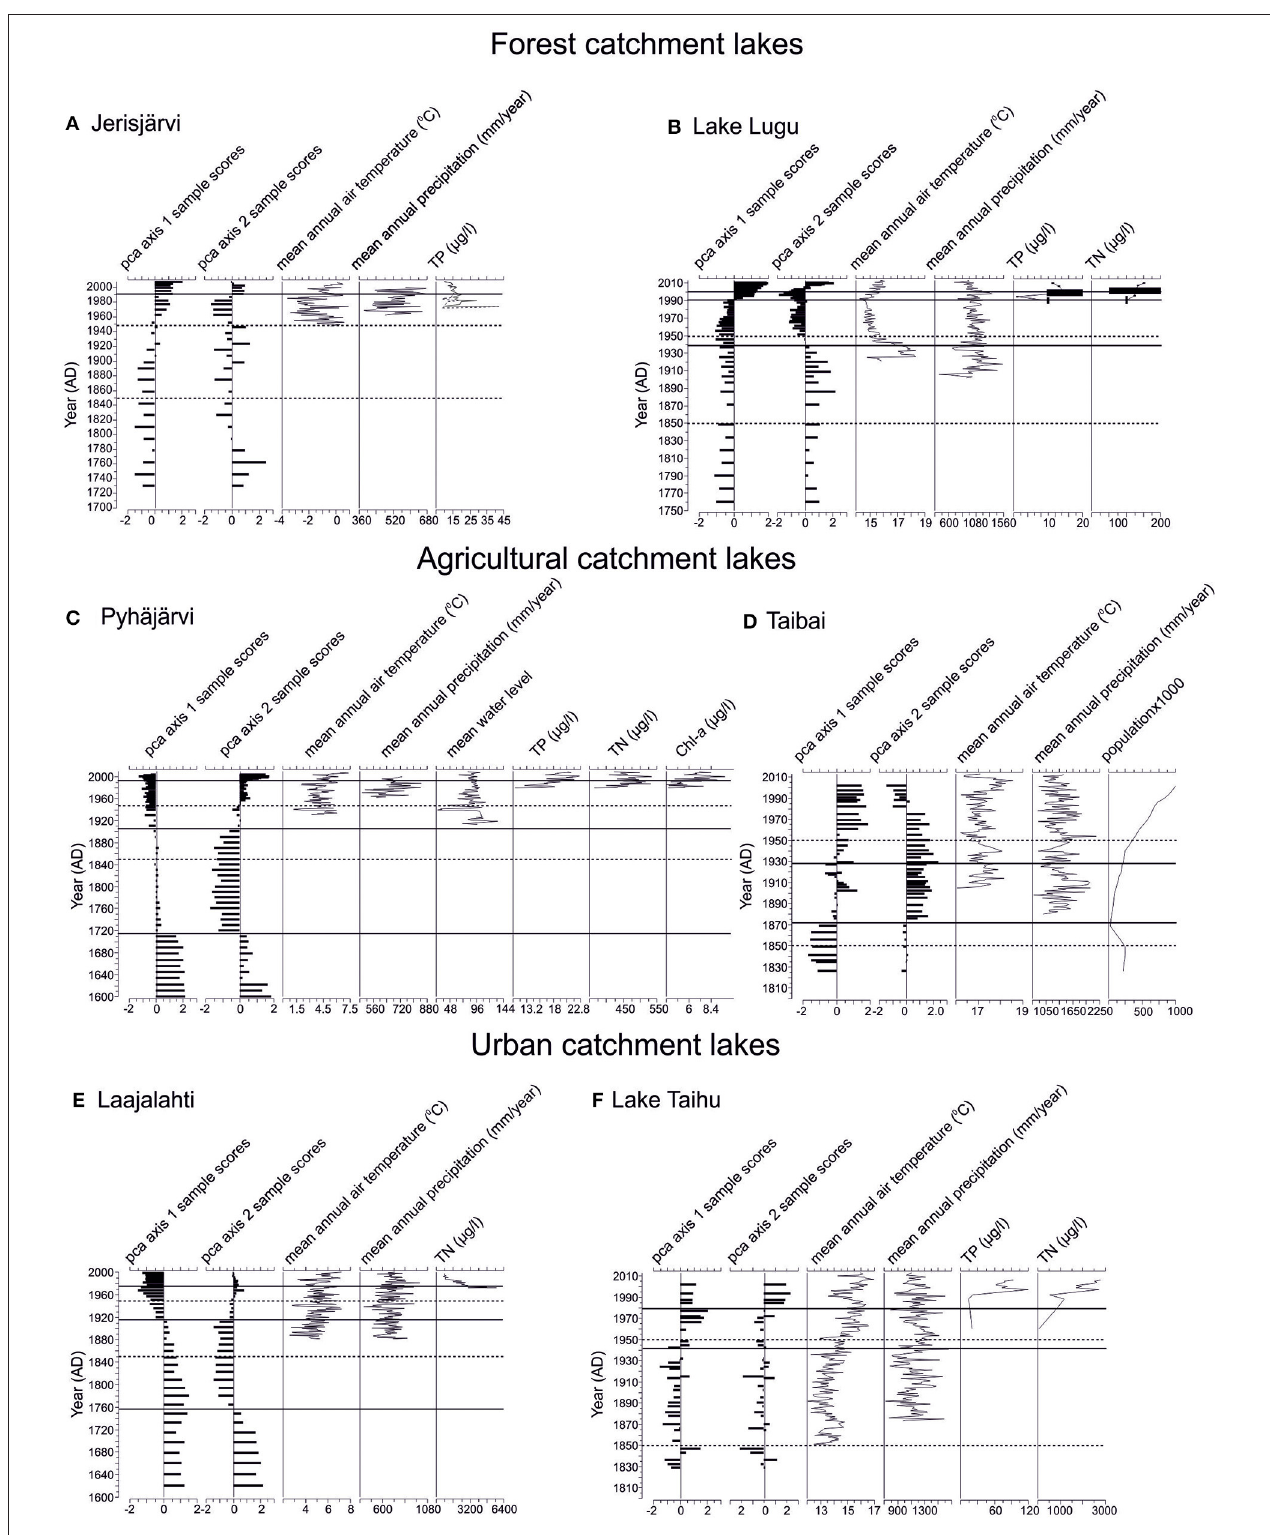
FIGURE 3 | Summary of the PCA 1 and 2 axis sample scores and documented values for annual mean air temperature, annual mean precipitation, water level changes, TP, TN, Chl- a , and human population, if available. The years 1850 and 1950, usually referred to as the timing of most intensive change